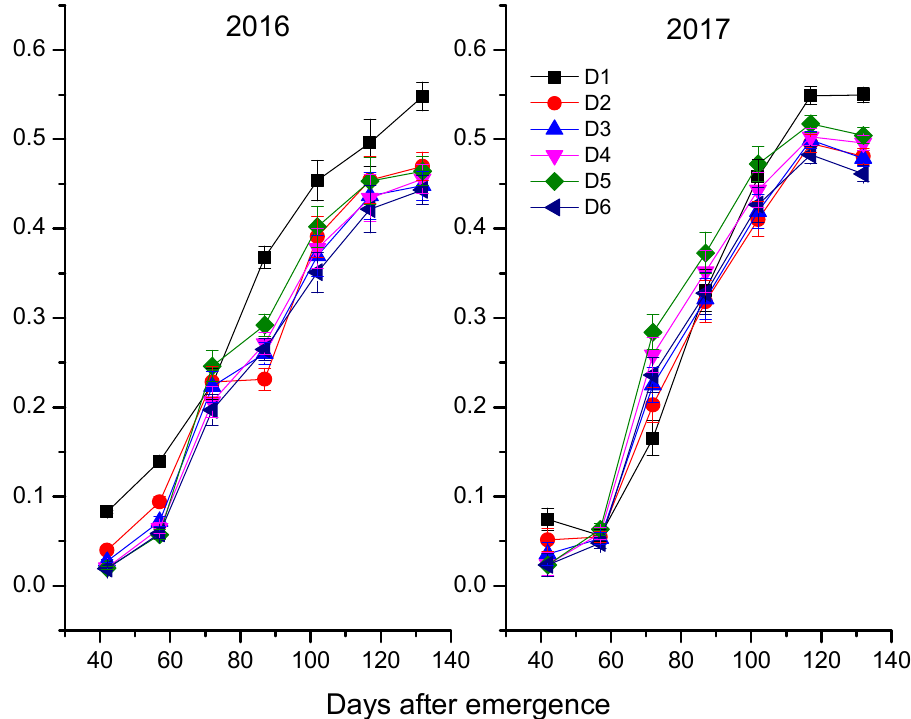
Figure 3. Ratio of dry weight of reproductive organs to plant biomass (DWRO / PB) in 2016 and 2017 growing seasons.